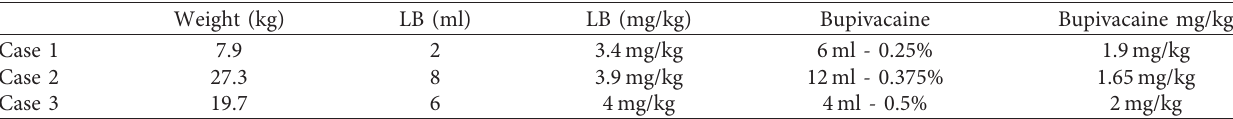
Table 2: A summary of the local anesthetic volume (ml) and dosage (mg/kg) used for each case is presented. The regular bupivacaine referred in the table was added to the liposomal bupivacaine to create the admixture used for the injection. Weight (kg) LB (ml) LB